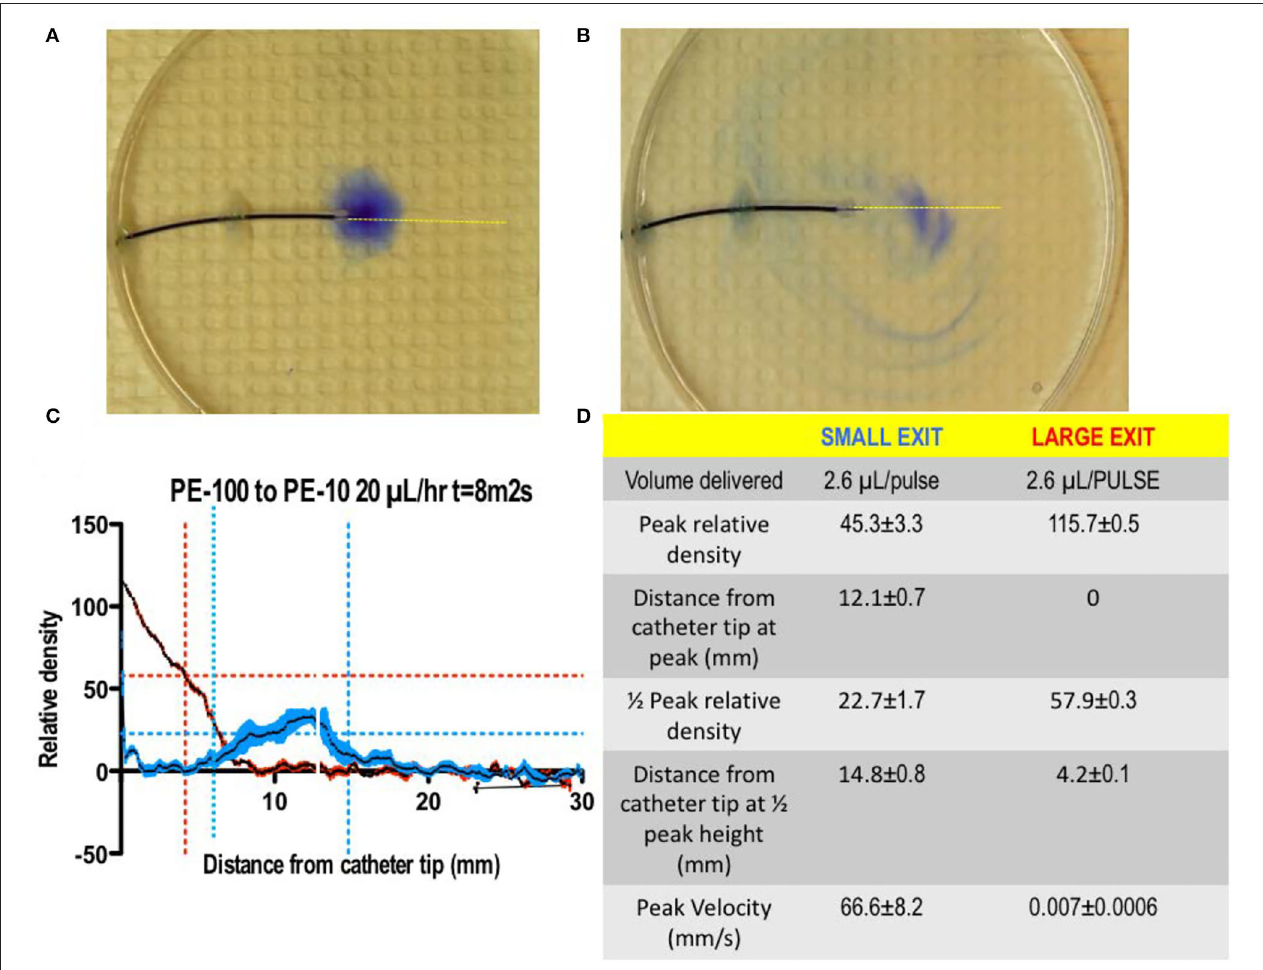
FIGURE 8 | (A,B) A photograph of the 2D diffusion chamber, assessing movement of a small volume of blue dye (2.6 µ L) delivered as a bolus through A: a small orifice (0.011” dia) vs. a large (0.34” dia) orifice. As indicated in (C,D) , the delivery through a small orifice resulted a high exit velocity with a reduced peak concentration and the shift of the peak concentration away from the catheter lumen as compared to the bolus delivery of the same volume of dye through a large lumen (T.L.